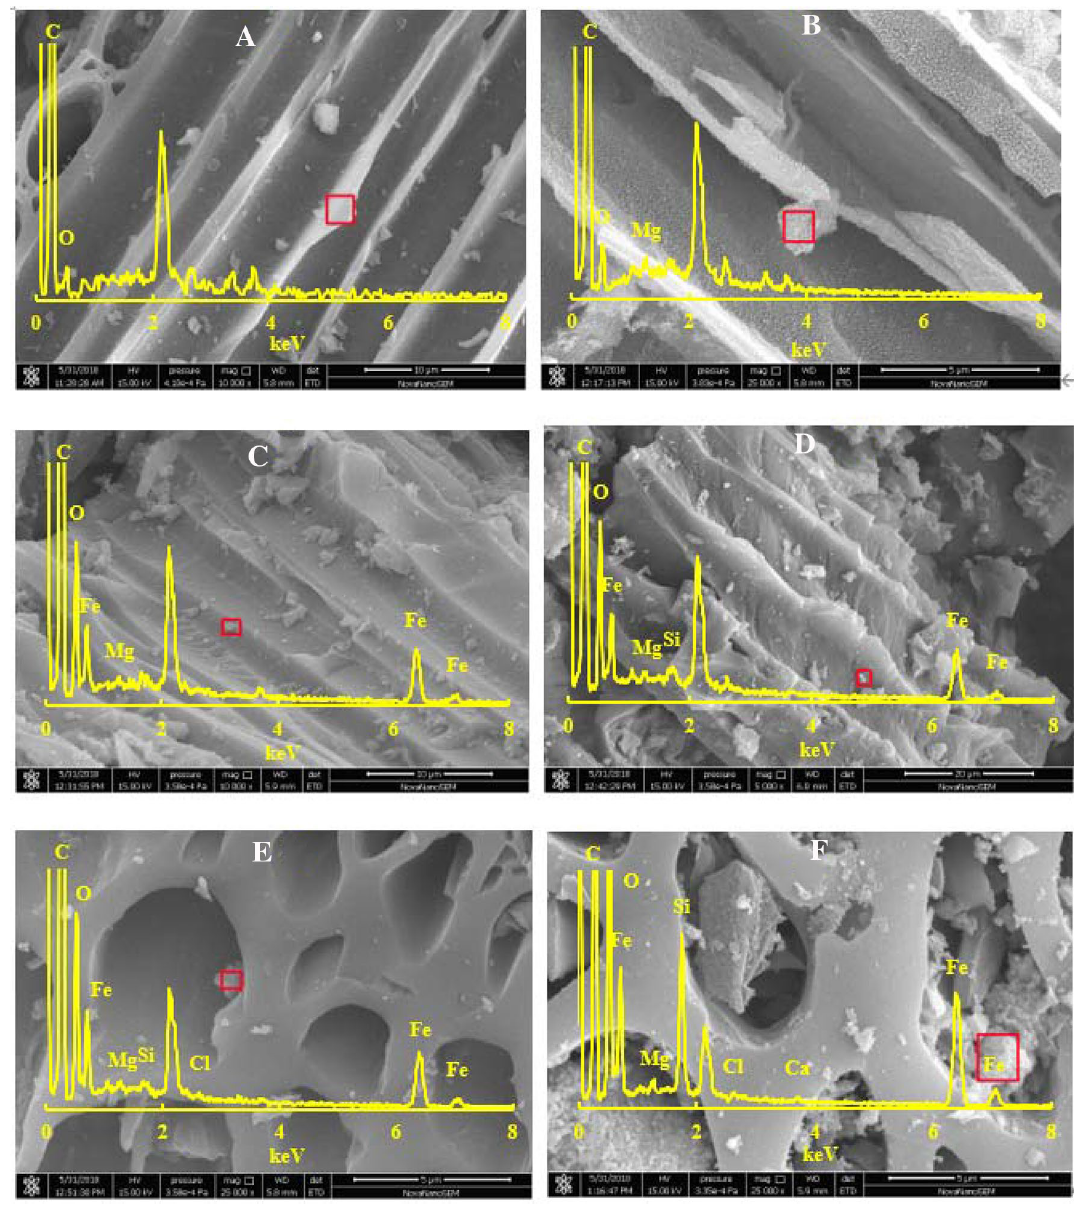
Figure 3. The SEM and EDS of BB ( A ), PB ( B ), ABB ( C ), APB ( D ), ABB sorbed 160 mg L −1 2,4,6-TCP ( E ) and APB sorbed 160 mg L −1 2,4,6-TCP ( F